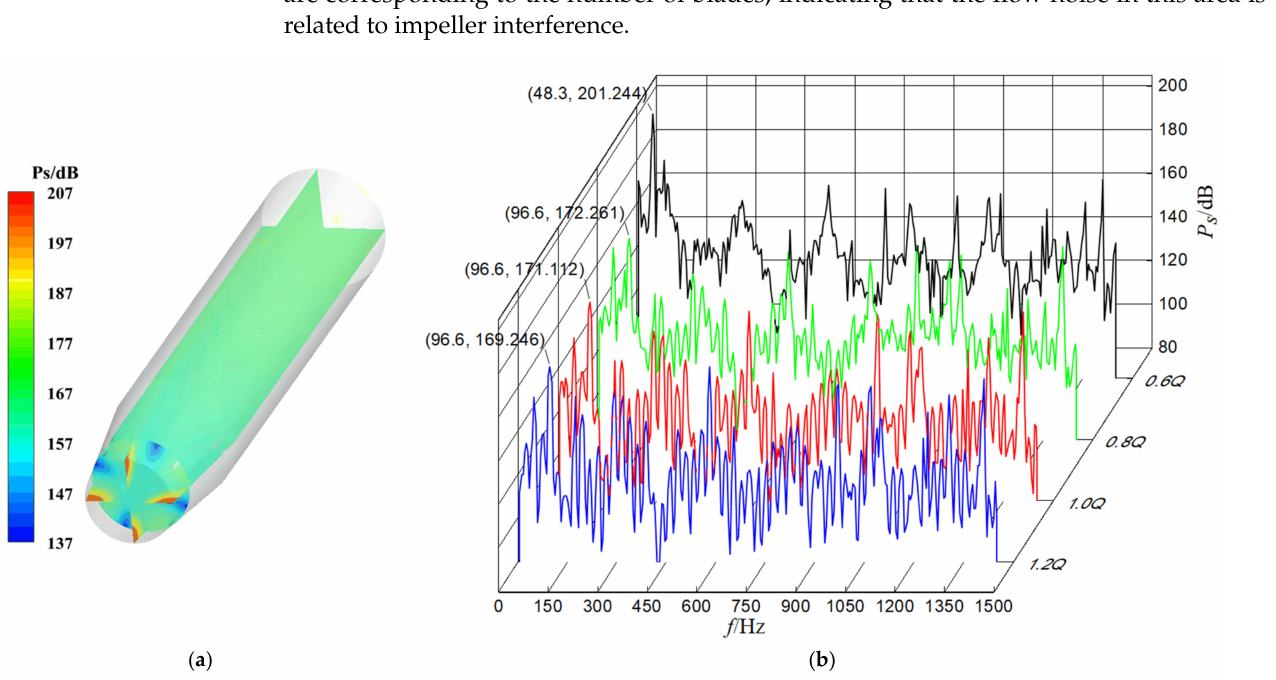
Figure 11. Flow noise results of Inlet area. ( a ) Sound pressure level distribution; ( b ) Spectrum diagram of sound pressure under different flow rate